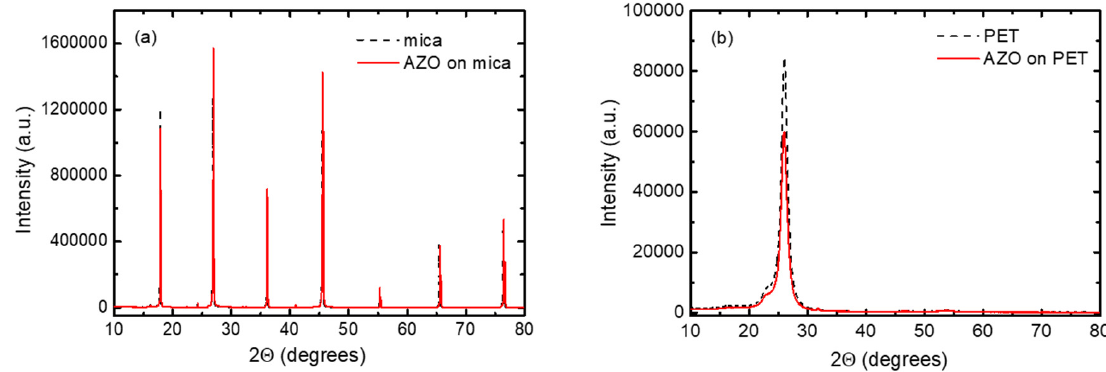
Figure 1. XRD of ( a ) AZO on mica and ( b ) AZO on PET (blank mica and PET are included as references).